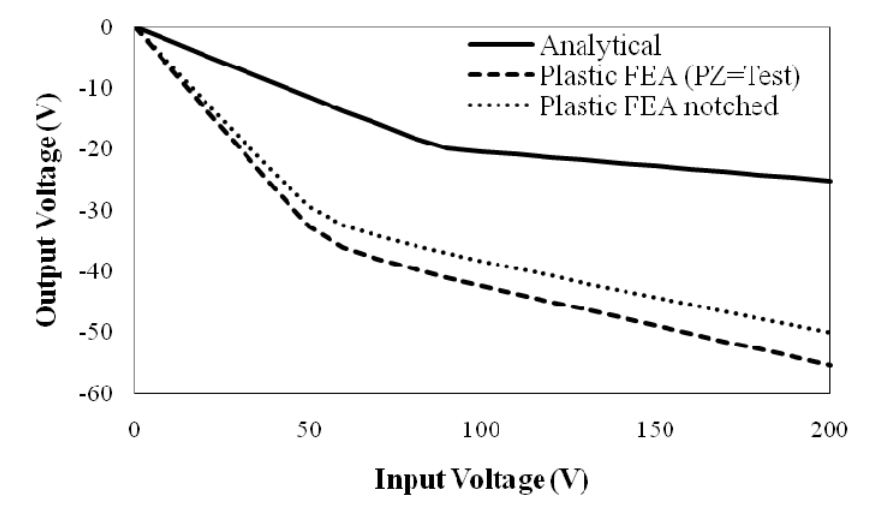
Figure 9. Comparison of the analytical and FE results using equivalent segments, and equivalent notched segments when plasticity is